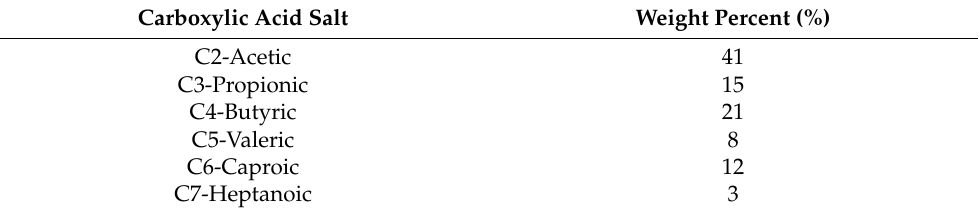
Table 2. Carboxylic Acid Salt Product Spectrum at 40 ◦ C [8]. Carboxylic Acid Salt Weight Percent